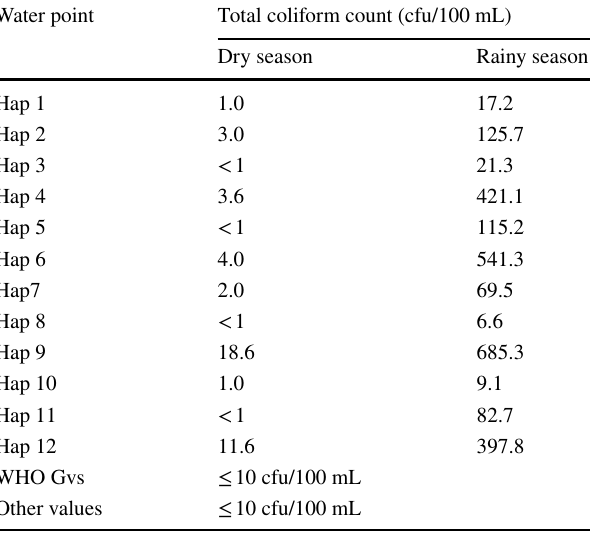
Table 2 Microbial Analysis of hand pump water samples